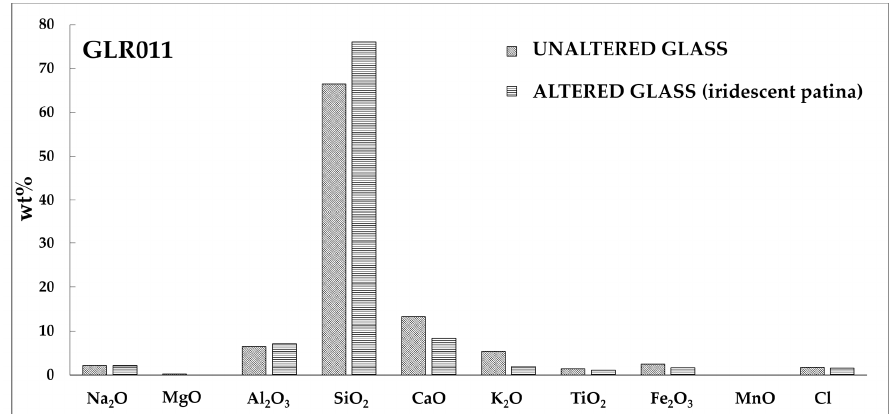
Figure 3. Mean concentrations (wt%) detected by SEM-EDS of the elements present on the altered (iridescent area) and unaltered area of sample GLR011.